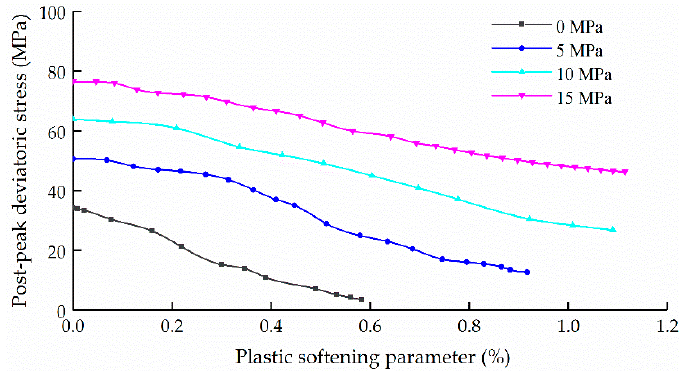
Figure 3. Relationship between post-peak deviatoric stress and plastic softening parameter.